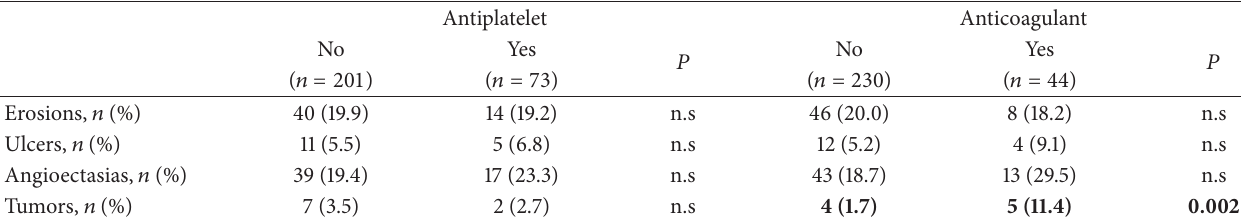
Table 3: SBCE findings in patients under antiplatelet and anticoagulant